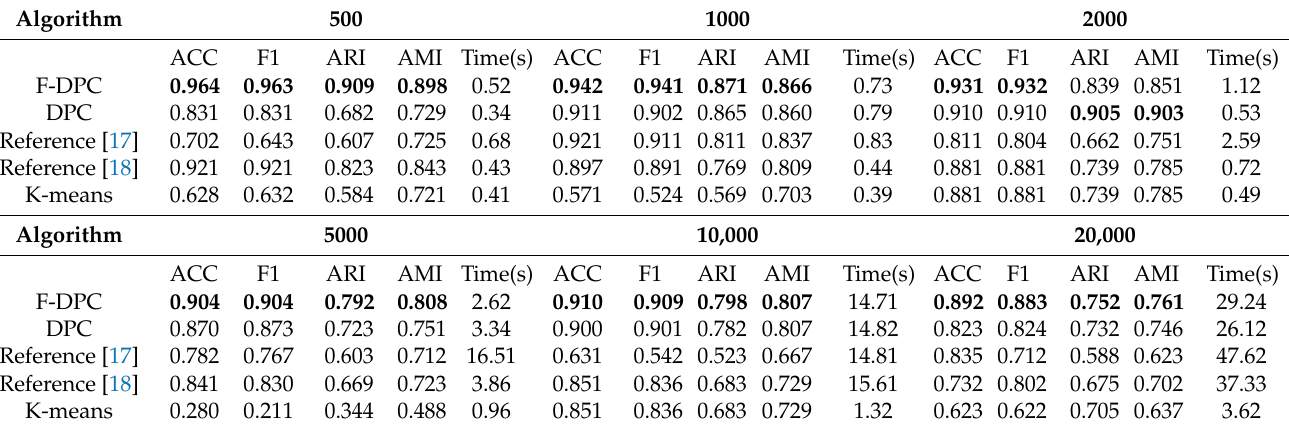
Table 2. Evaluation metric values and times on different numbers of datasets.